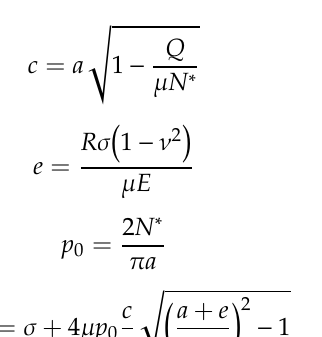
Table 3 . Load combinations and related Hertzian parameters.